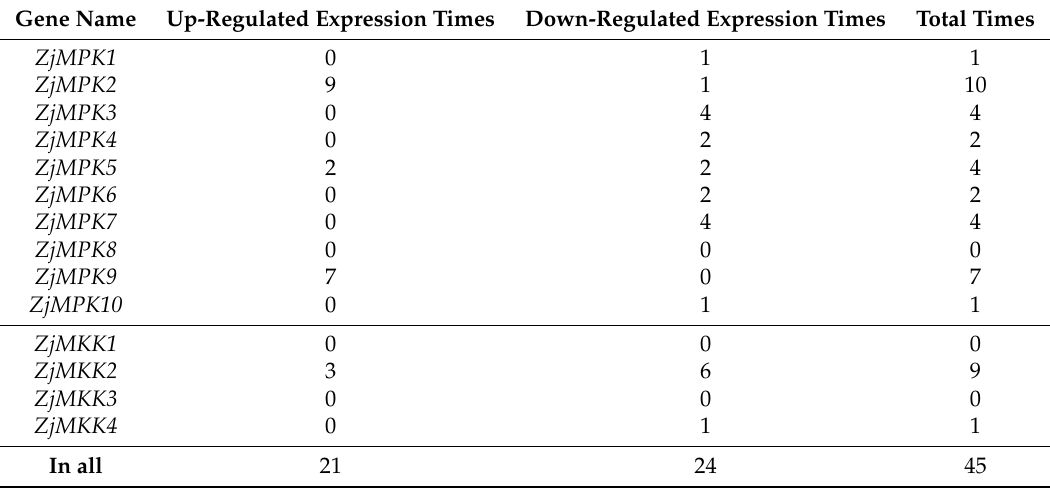
The number of ZjMPK and ZjMKK genes with significant di ff erence expression in non-symptomatic leaves, phyllody and small leaves at five